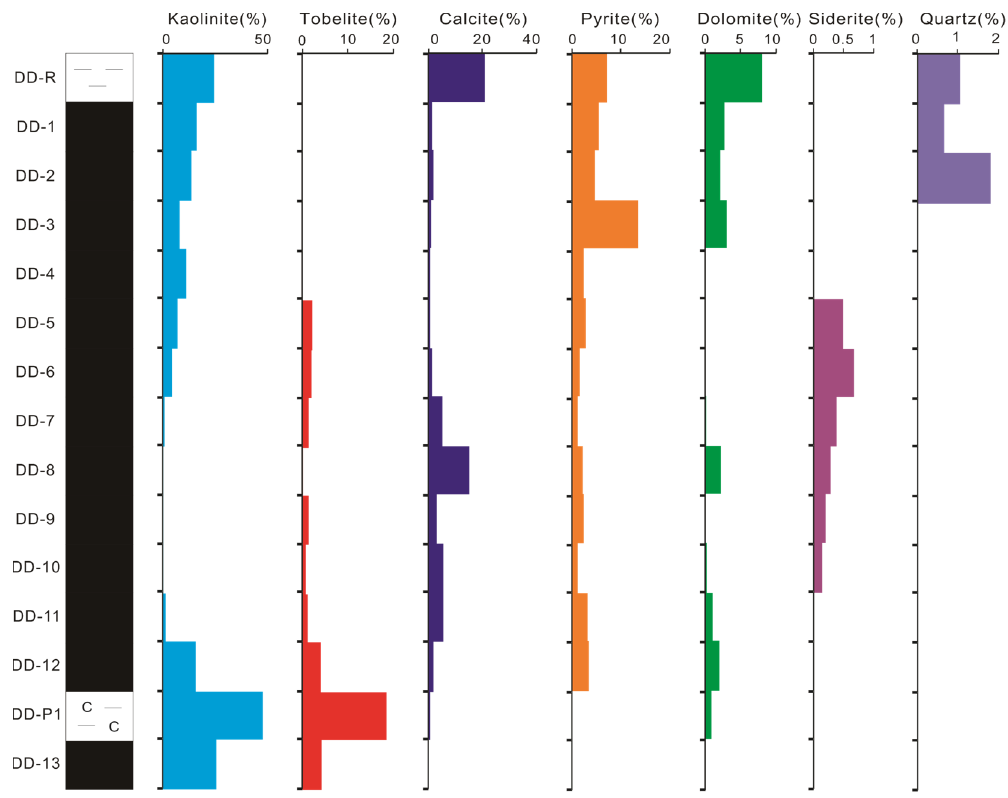
Figure 14. Vertical variations of primary minerals expressed as percentages of each whole-coal or rock sample in the Dongdongcoal mine.